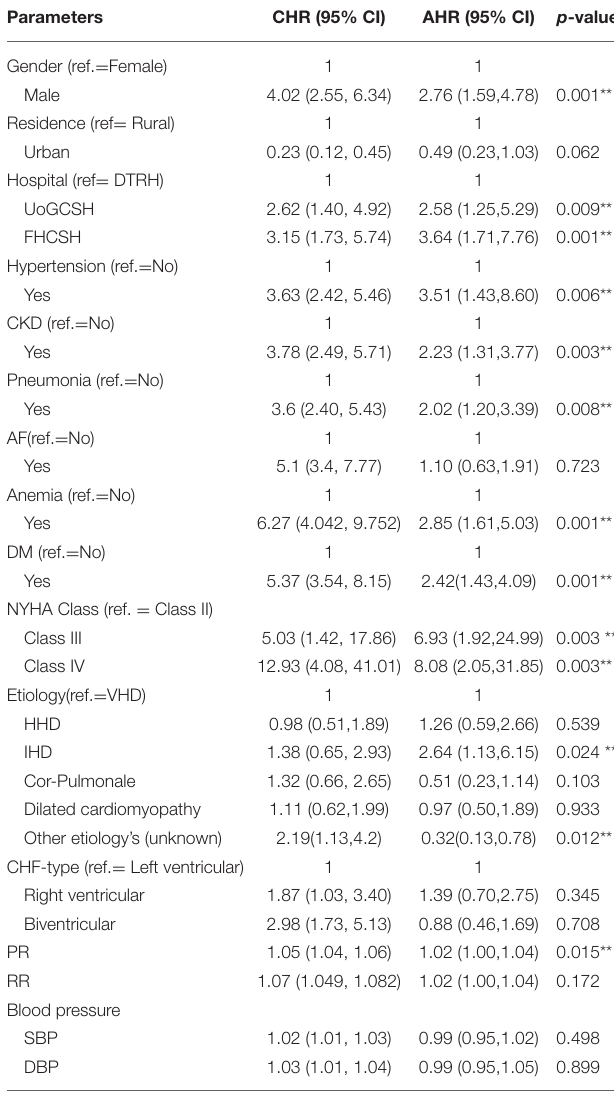
TABLE 5 | Univariable and multivariable Cox regression analyses of predictors of mortality among patients with CHF in three selected Amhara Region